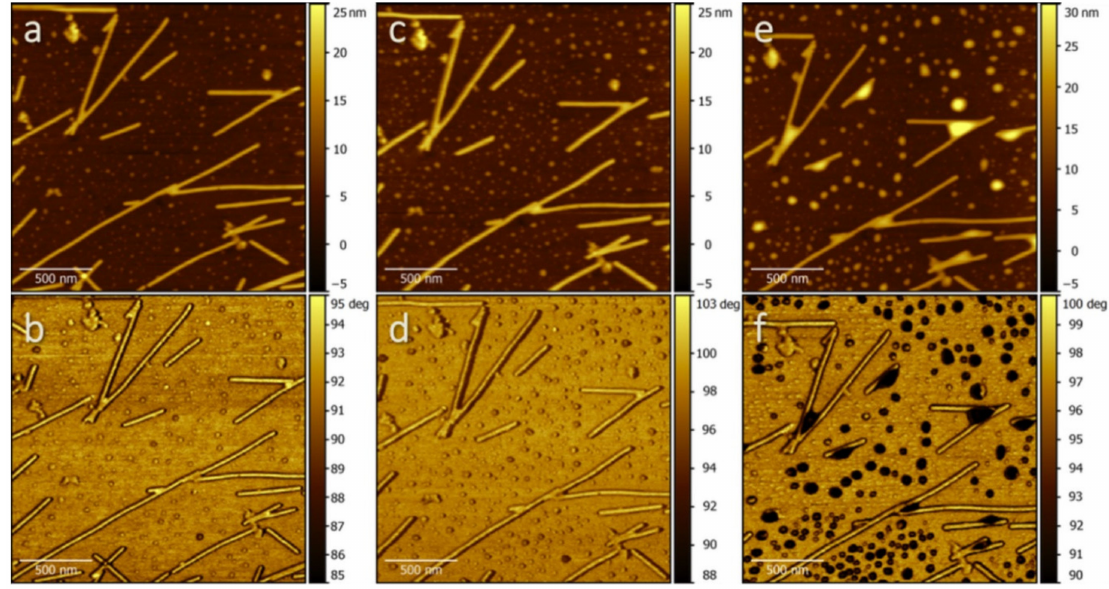
Figure 2. Sequence of AFM topographic images ( a , c , e ) and corresponding multifrequency Φ 2 images ( b , d , f ) collected at RH = 56% ( a , b ), 76% ( c , d ), and >100% ( e , f